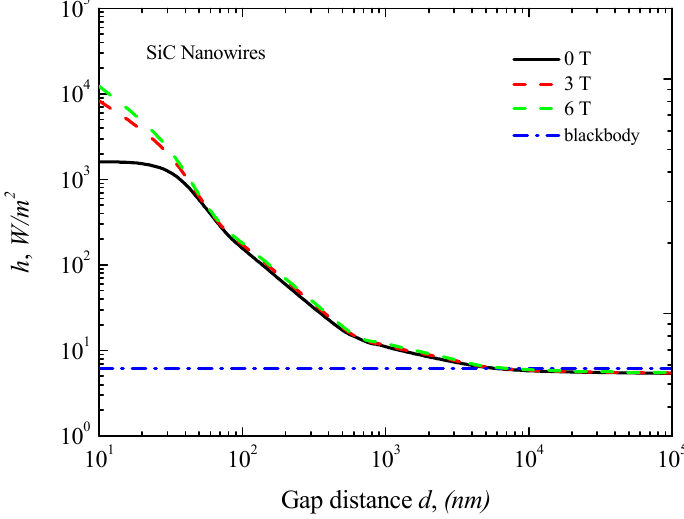
Figure 8. Heat transfer coefficient versus gap distance and a filling ratio of 0.2.